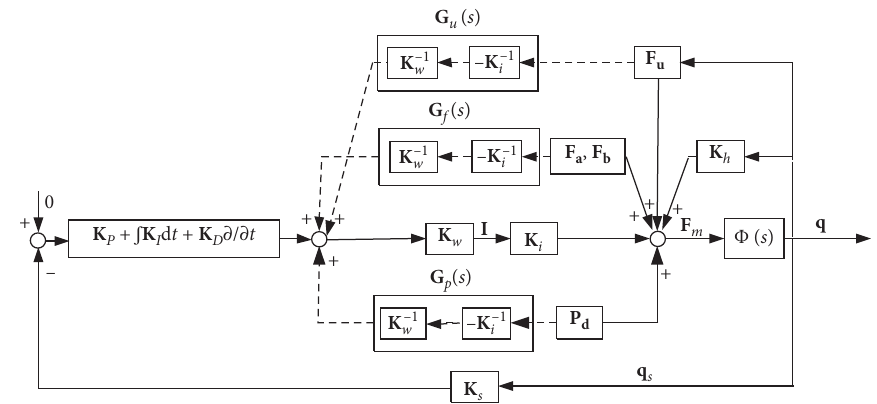
Figure 3: Control block diagram with feedforward compensation.